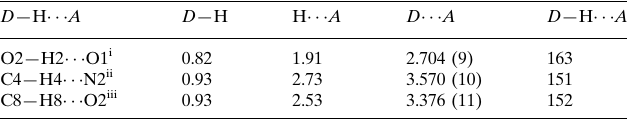
Hydrogen-bond geometry (A˚ , (cid:1)